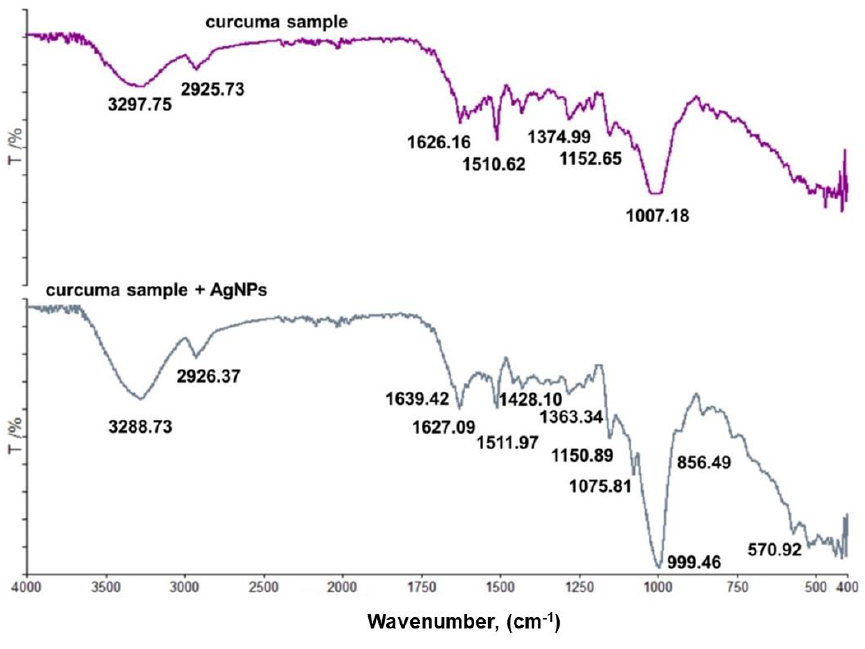
Figure 4. FTIR spectra of sodium-citrate-coated silver nanoparticles ( a ) and sodium citrate ( b ).